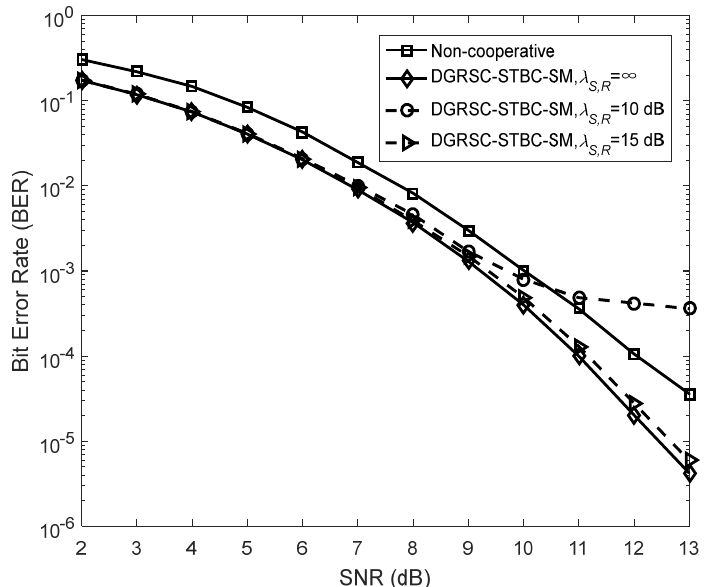
Figure 7. Comparisons between DGRSC − STBC − SM employing C S ( 10, 5, 6 ) and C R ( 10, 3, 8 ) and non − cooperative counterpart under Algorithm 1 , N t = N r = 4 and BPSK.